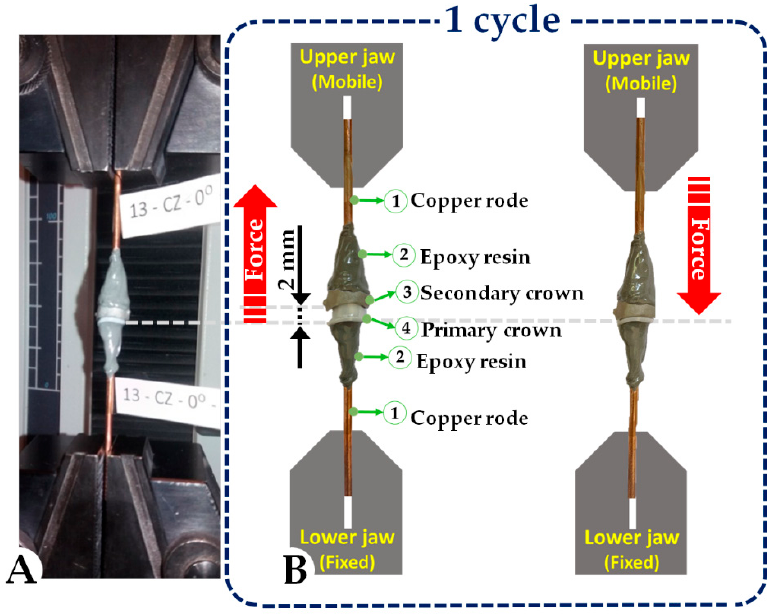
Figure 3. Image of the mechanical testing set-up ( A ) and schematic representation of 1 cycle ( B ).